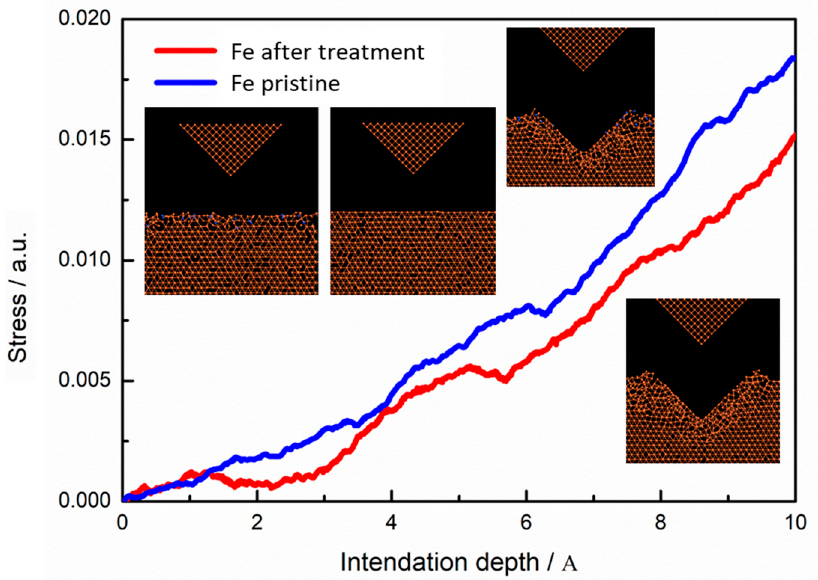
Figure 13. Simulation results of